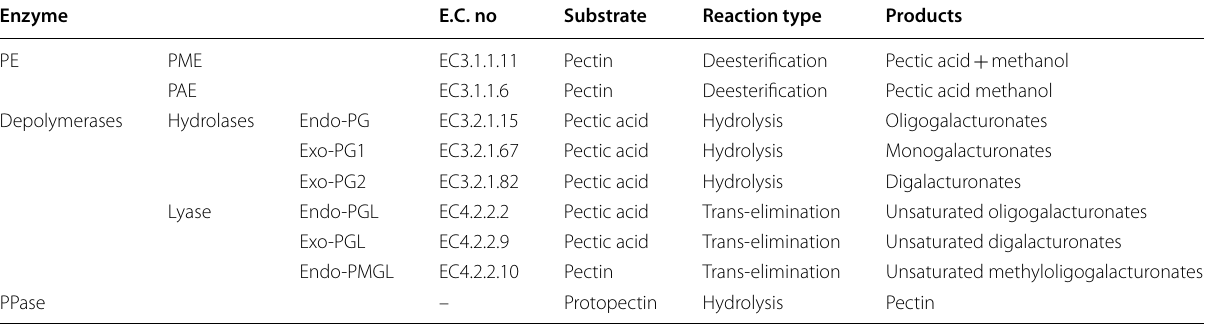
Table 1 Classification of